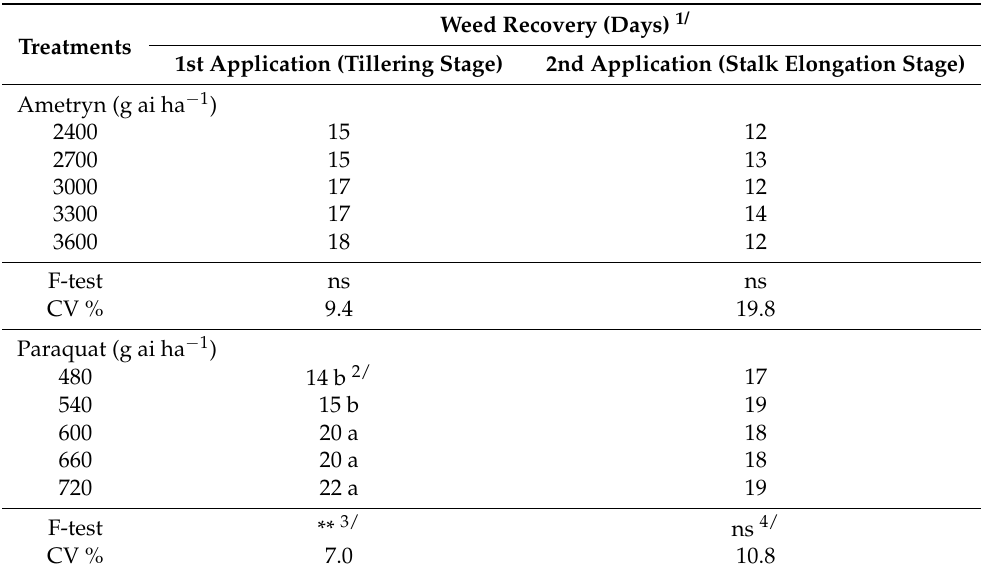
Table 2. Effects of ametryn and paraquat applications at various rates on weed recovery in Experi- ment